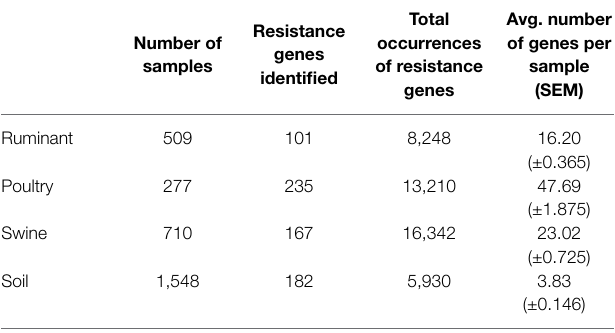
TABLE 3 | Total antimicrobial resistance gene (ARGs) per